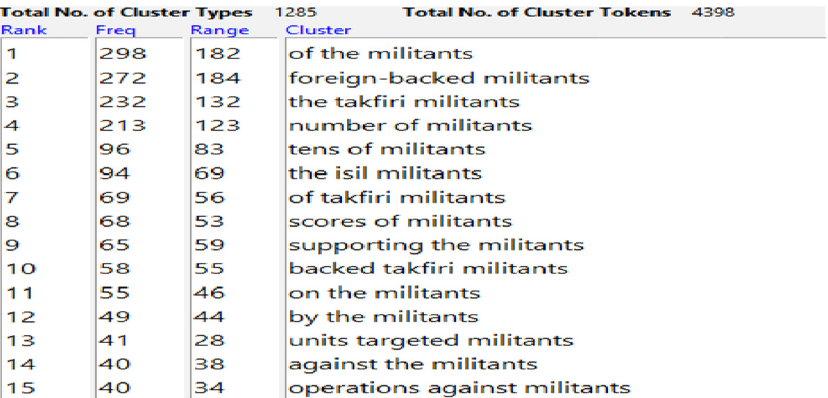
Figure 4: Lexical clusters of